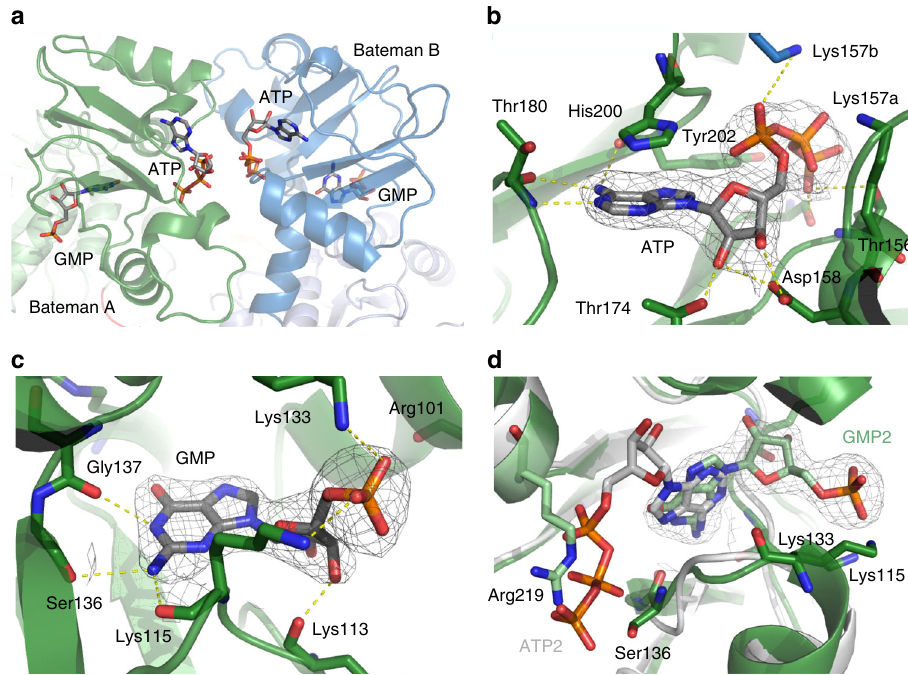
Fig. 5 Nucleotide binding to the Bateman domain of TbIMPDH. a Electron density detected in two clefts on the surface of the Bateman domain of each monomer in the ASU was assigned to the coordination of one ATP and one GMP molecule in the canonical nucleotide binding sites. b , c Detailed view of the ATP and GMP binding. The protein is shown as green cartoons and the nucleotides as gray sticks. The side chain of Lys157 ’ from the neighboring monomer is colored in blue. The ATP and GMP as well as interacting residues are displayed as sticks. Yellow dashes represent hydrogen bonds. d Superposition of the second canonical binding site of TbIMPDH-ATP1/GMP2 (green) with that of AgIMPDH-ATP1/ATP2 (gray). Due to the fl ipped binding mode of GMP2 in TbIMPDH, the side chain of Arg219 occupies the space required for the phosphate groups of ATP2 in AgIMPDH. In b – d , the displayed 2F o F c -electron density is countered at 1.0 sigma.